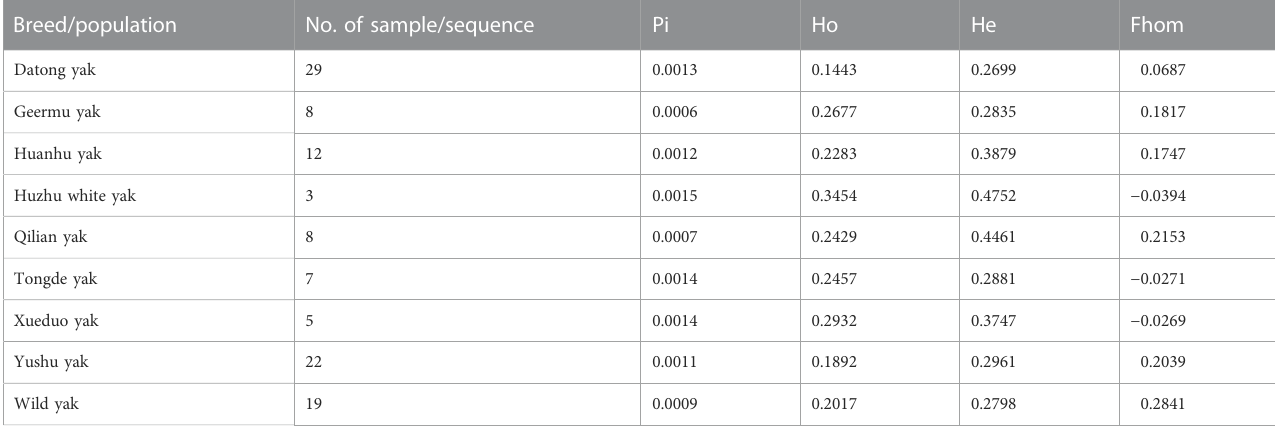
TABLE 1 Genetic diversity indexes of nine yak breeds/populations in Qinghai, China. Breed/population No. of sample/sequence Pi